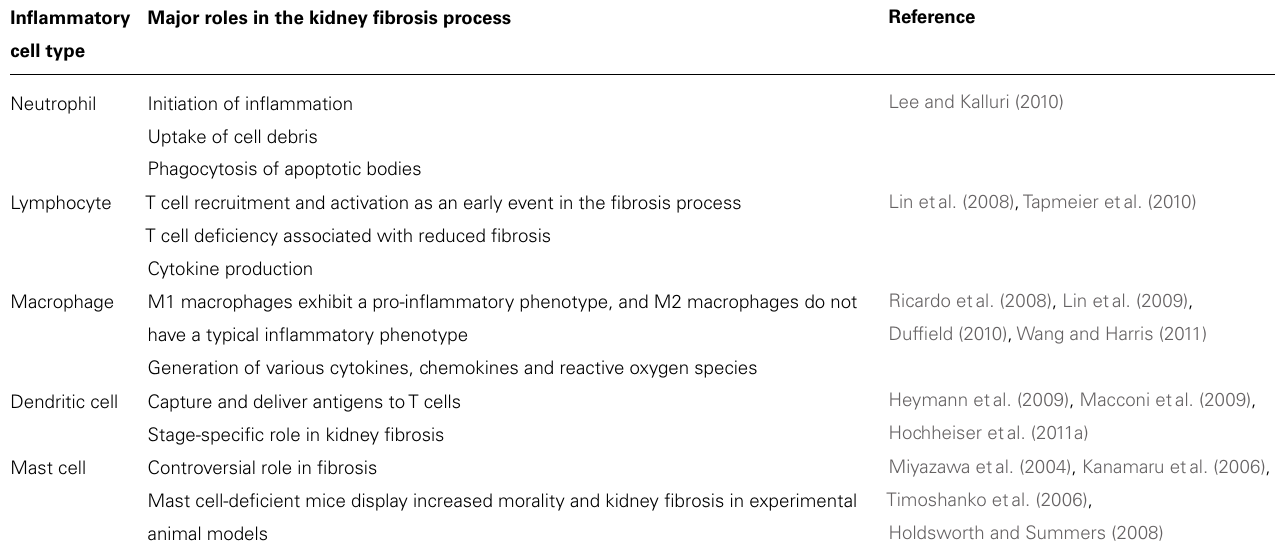
Table 1 | Inflammatory cell types and their roles in kidney